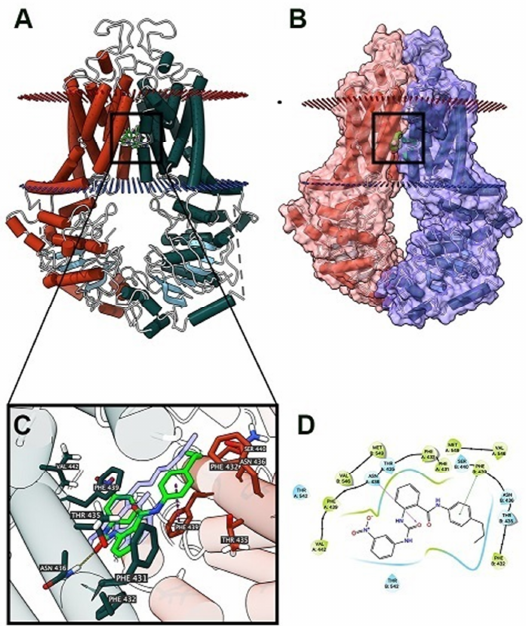
Figure 8. The molecular modeling of VKNG-2 and human ABCG2. ( A ) An overview of mitoxantrone and the best-scoring pose of VKNG-2 in the drug-substrate binding site of the ABCG2 protein (6VXI). The cytoplasm membrane is depicted as dotted planes, where the red or blue planes indicate the extracellular or intracellular side, respectively. ABCG2 is displayed as colored tubes and ribbons. VKNG-2 and mitoxantrone are displayed as colored sticks. Carbon: lime green (VKNG-2) or white (mitoxantrone); oxygen: red; nitrogen: blue. ( B ) Mitoxantrone and the best-scoring pose of VKNG-2 in the drug-substrate binding site of the ABCG2 protein with molecule surface displayed. ( C ) Details of the interactions between VKNG-2 and the ABCG2 (6VXI) drug-substrate binding site. ABCG2 protein helices are displayed as colored tubes (chain A: green; chain B: red). Important residues are displayed as colored sticks (carbon: same as chain color; oxygen: red; nitrogen: blue). VKNG-2 is displayed as colored sticks (carbon: lime; oxygen: red; nitrogen: blue). Hydrogen bonds are displayed as yellow dash lines. p-p stacking interactions are displayed as magenta dash lines. ( D ) 2D diagram of the interaction between VKNG-2 and ABCG2. Important amino acids are displayed as colored bubbles (green: hydrophobic; blue: polar). Purple solid lines with an arrow indicate hydrogen bonds. Green solid lines without arrow indicate p-p stacking